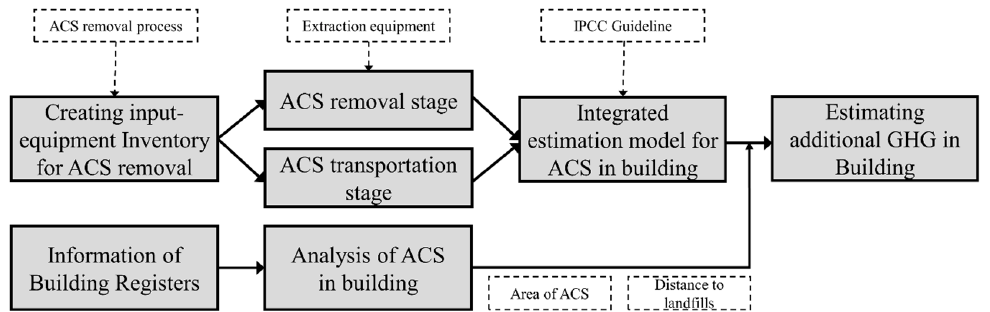
Figure 1. Overview of the methodology applied in this study to achieve Objective 1: developing an integrated estimation model; and Objective 2: calculating the total greenhouse gas (GHG) emissions generated by asbestos cement slates (ACS) removal for all of the buildings in Korea.